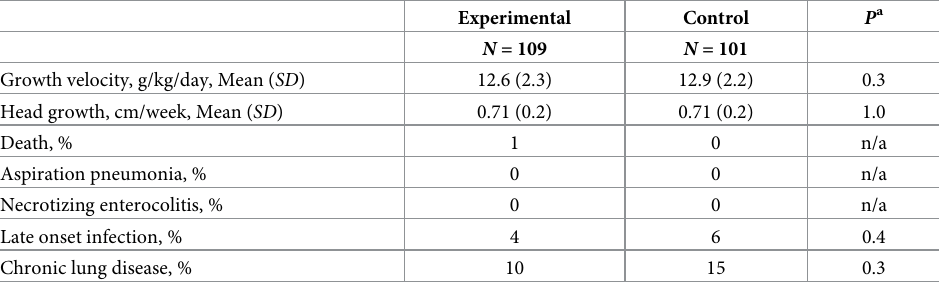
Table 3. Neonatal